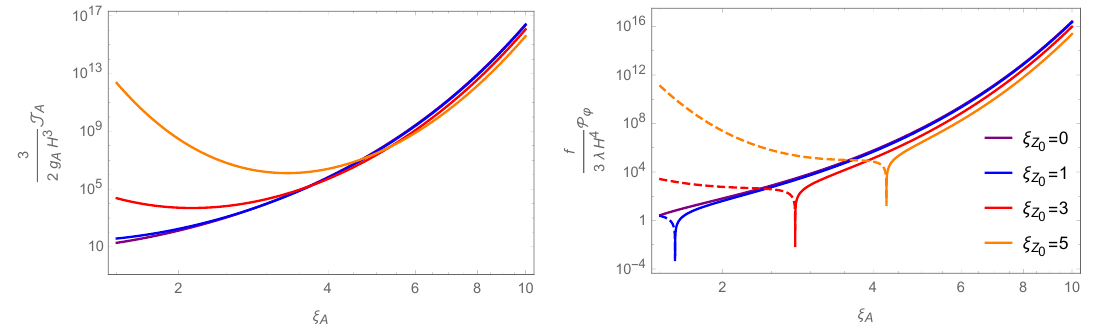
Figure 5 . Backreaction terms on the gauge ( J A ) and axion ( P ’ ) (cid:12)elds as a function of (cid:24) A and (cid:24) Z . The dashed lines show negative values. We show 3 0